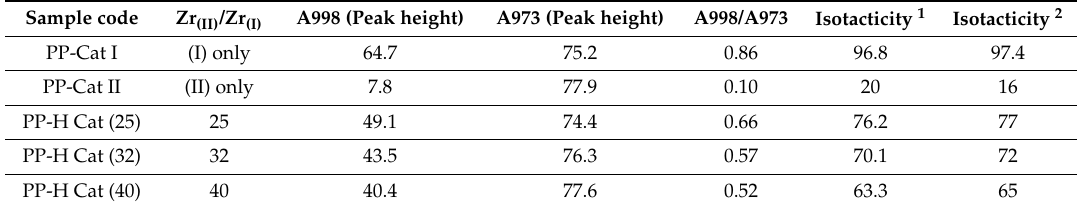
Figure 2. FTIR spectra of PP reactor blends synthesized with the binary and individual catalyst systems. Table 3. FTIR results of PP reactor blends synthesized with the binary and individual catalyst